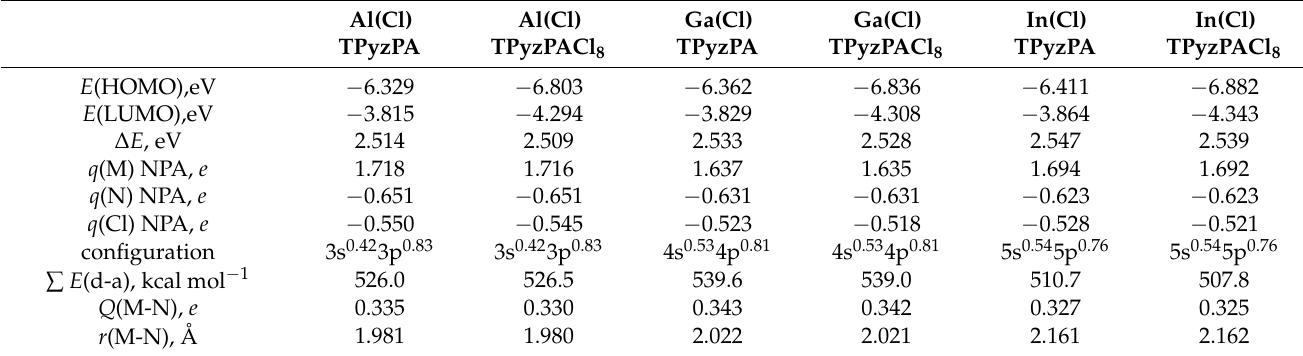
Table 2. Selected parameters of M(Cl)PyzPA complexes from NBO